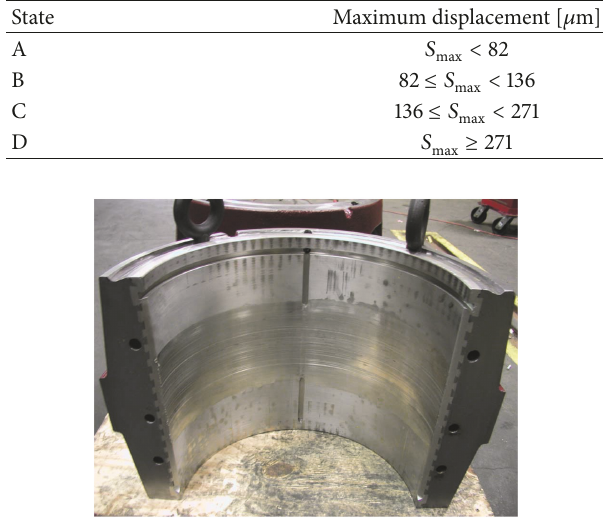
Figure 8: Guide bearing